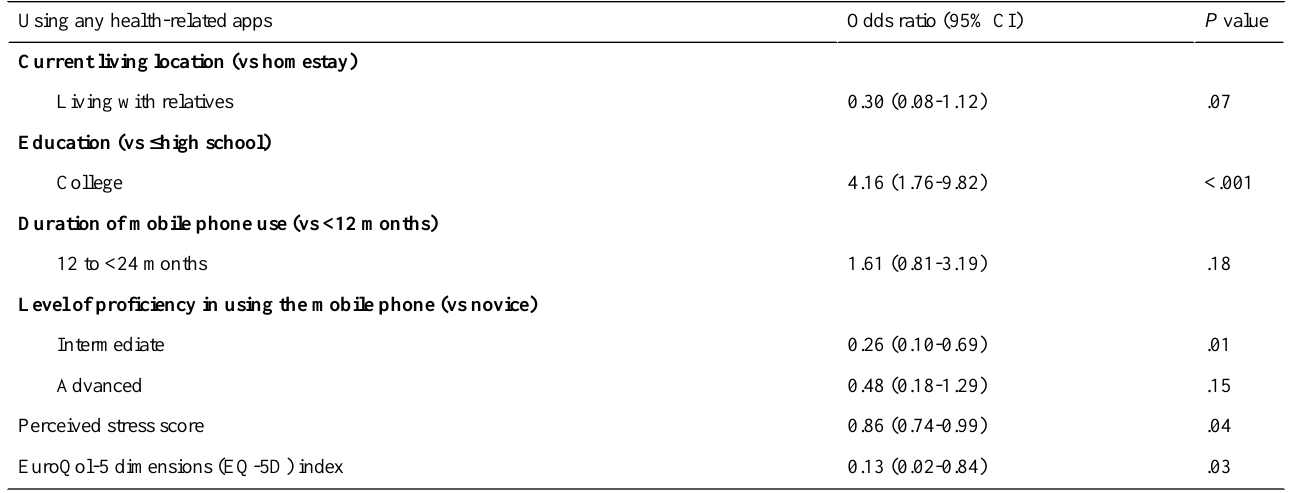
Table 4. Associated factors with the use of mobile phone health-related apps.